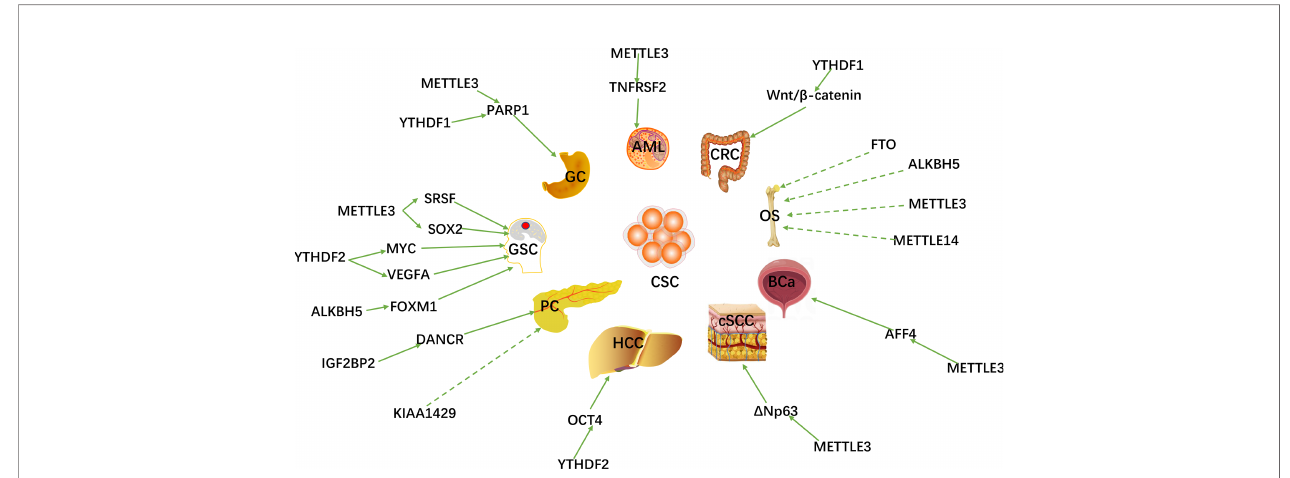
FIGURE 2 | The m6A regulators are involved in various peripheral CSCs and